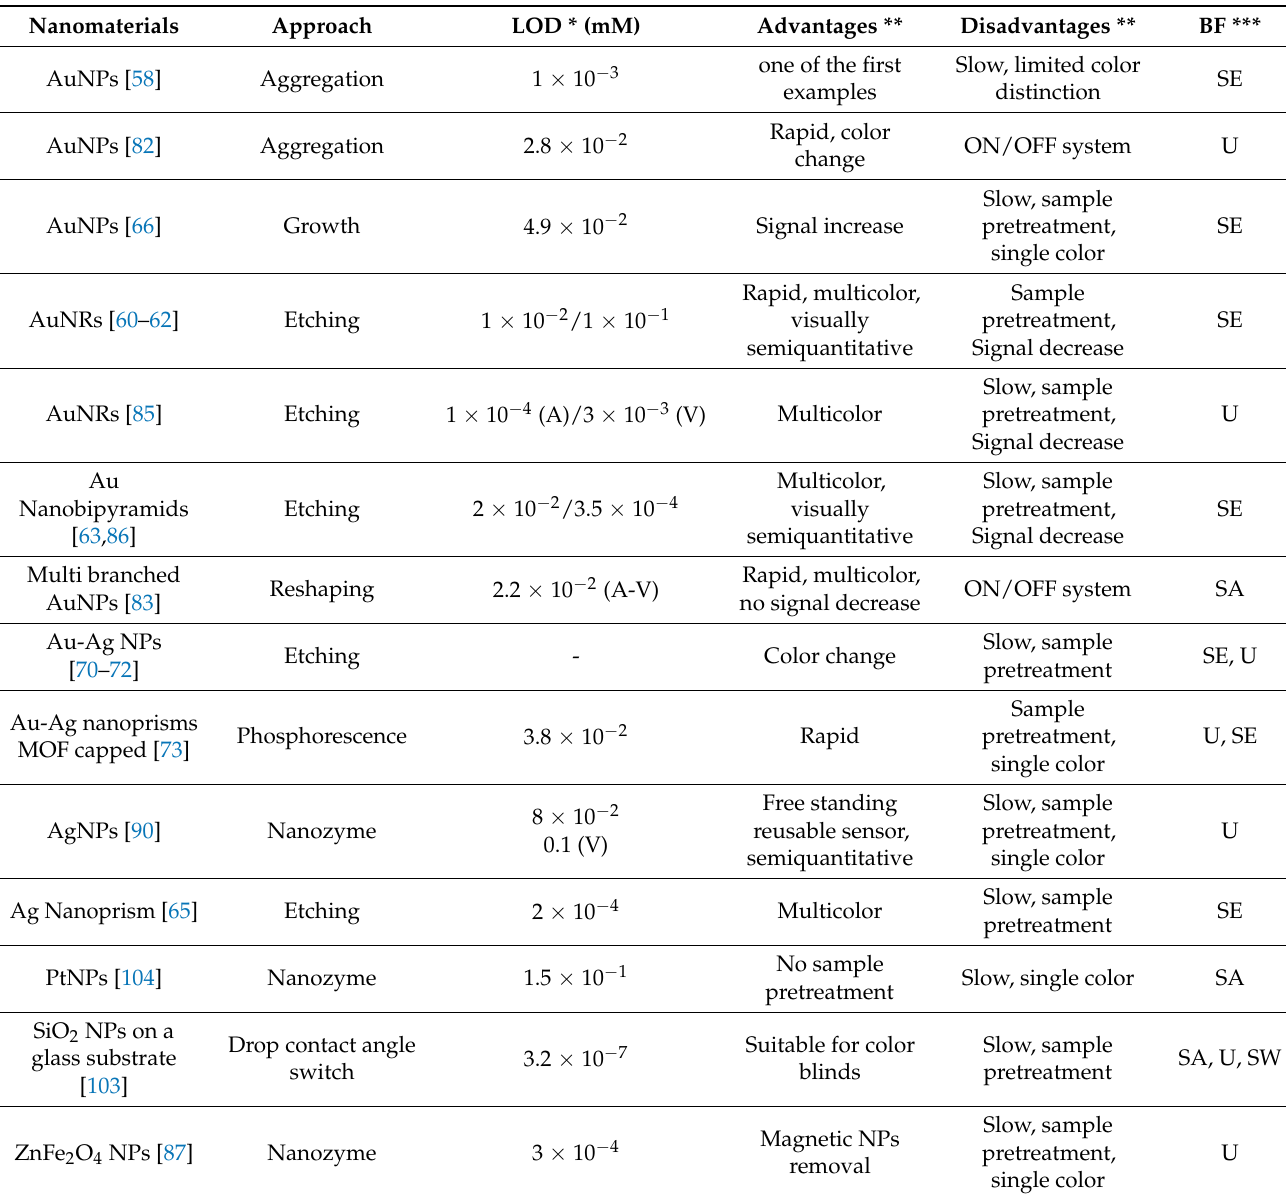
Table 1. Summary of the Nanomaterials and approaches described in this Review (example in artificial biofluids are not